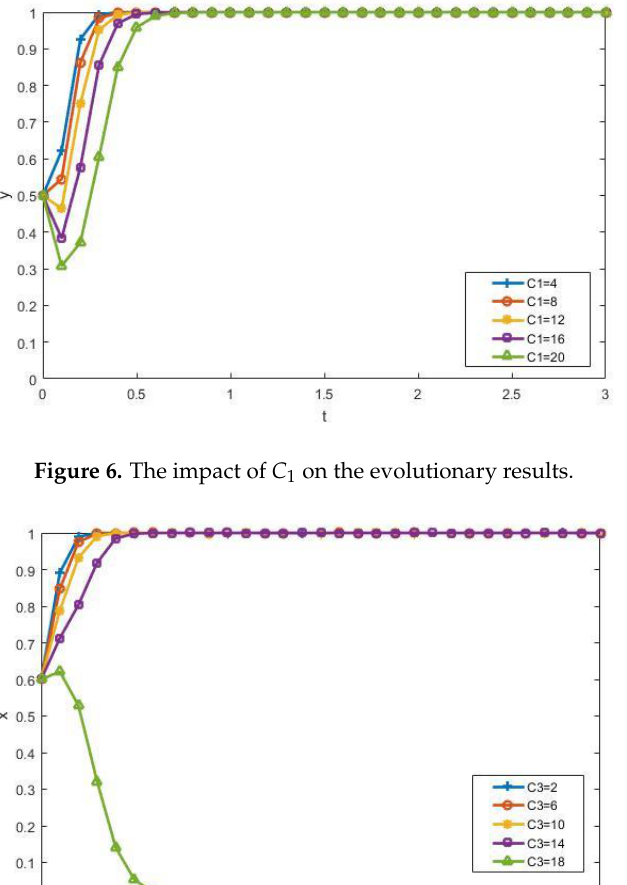
Figure 6. The impact of C 1 on the evolutionary results.